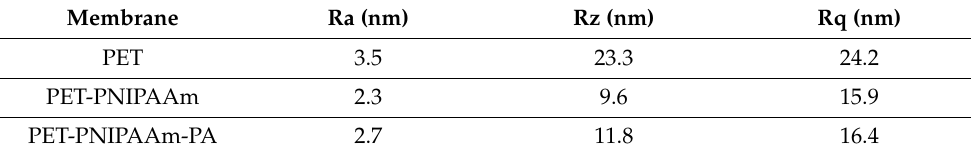
Figure 2. Surface and cross-sectional SEM and AFM images of ( a ) PET ( b ) PET-PNIPAAm ( c ) PET- PNIPAAm-PA membranes. Table 1. Membrane surface roughness parameters from